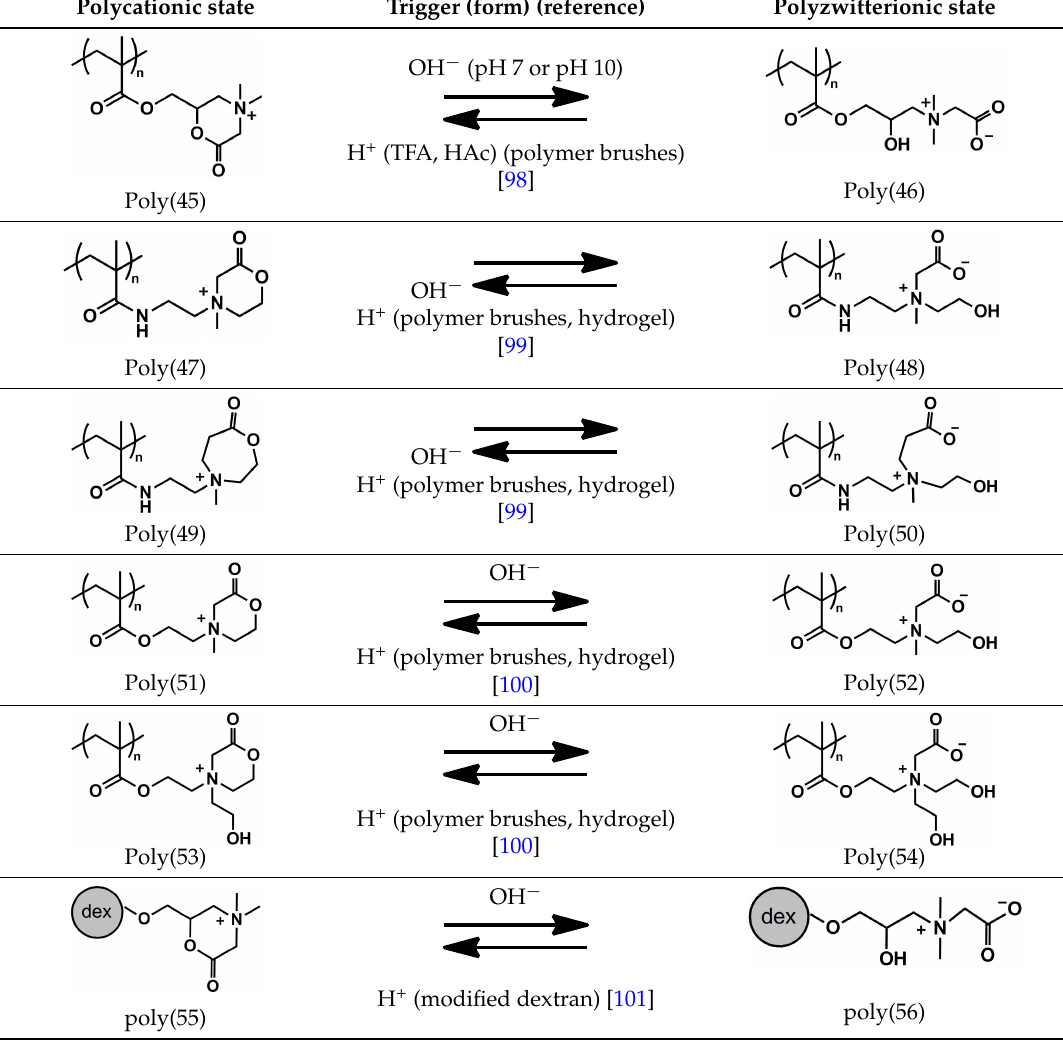
Table 6. Reversible switches containing polyzwitterionic state.